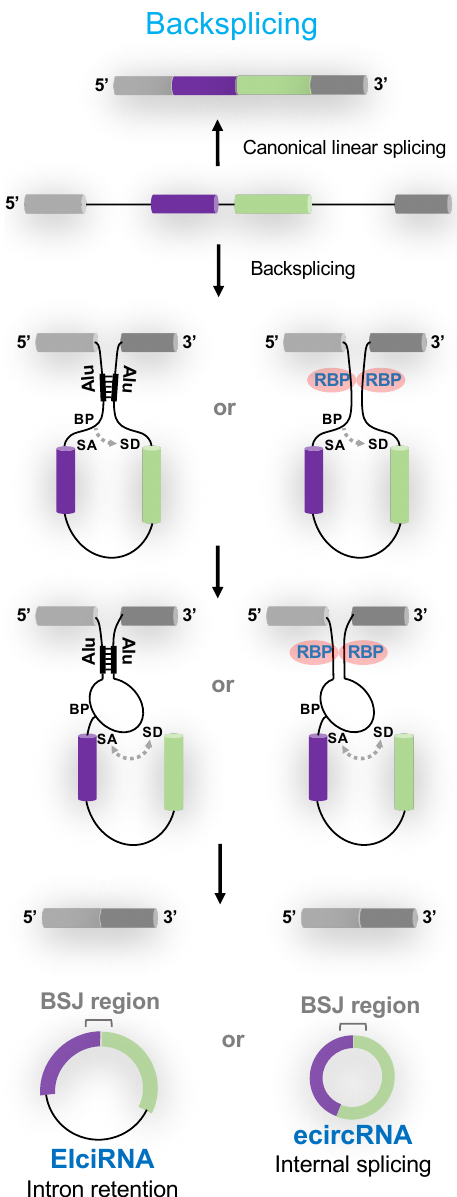
Figure 1. Biogenesis of circular RNAs. A signature, 7-nt GU rich motif near the 5’ splice site and an 11-nt C-rich motif at the branchpoint site, is critical for RNA lariats to escape debranching, thereby generating ciRNAs and ecircRNAs (after another backsplicing step). Backsplicing occurs in the presence of flanking inverted repeat elements (e.g., Alu elements) and / or with the aid of RNA-binding proteins (RBP). EIciRNAs and ecircRNA are both circRNAs, which require backsplicing in biogenesis. SA, splicing acceptor. SD, splicing donor. BP, branching point. BSJ, backsplice joint. Colored boxes depict exons. Black lines depict introns.